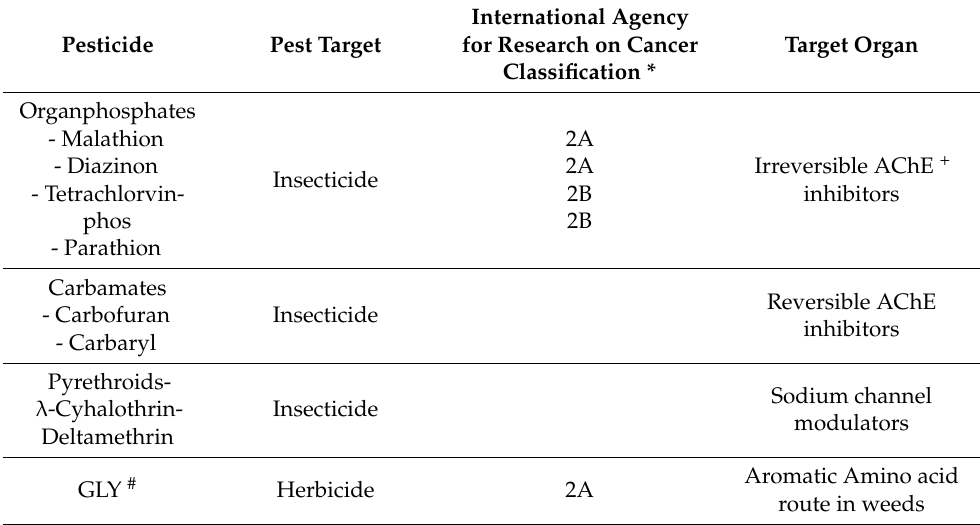
Table 2. Classification of pesticides and